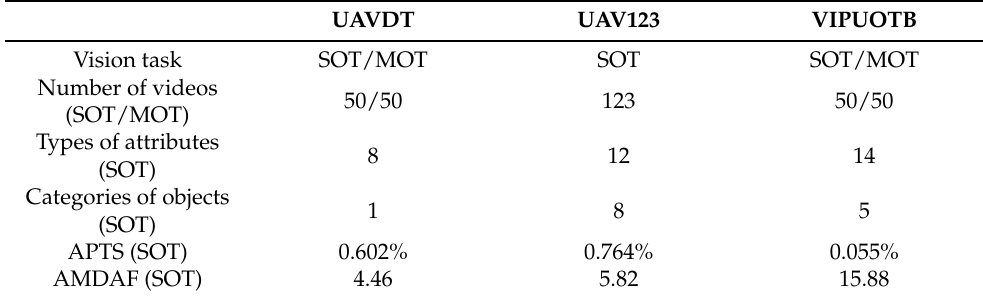
Table 3. VIPUOTB statistics and the comparison results with other UAV